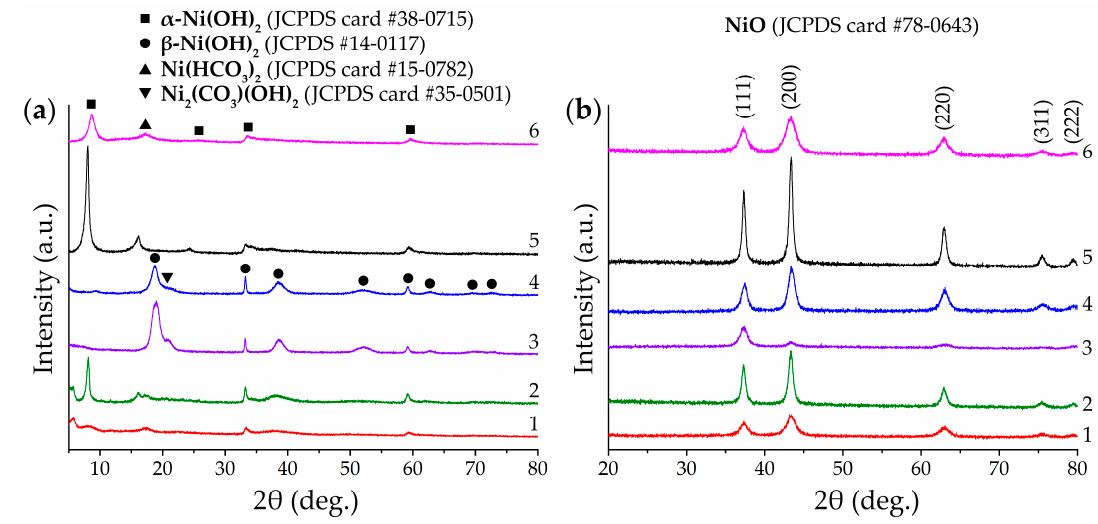
Figure 2. XRD patterns of semi ‐ products ( a ) and corresponding NiO powders ( b